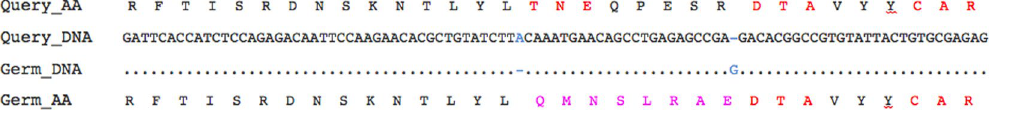
Figure 4. The igBlast alignment of a Prime Motif matching subsequence with its germline origin. The subsequence includes all three motif components; TNE, DTA, and CAR. These components have been highlighted in red. The nucleotide contents of the queried input sequence are listed on the line marked Query_ DNA. The proper amino acid translation of the query is included on the line marked Query_AA. The third line, labeled as Germ_DNA, features an alignment between the query nucleotides and the germline sequence IGHV3-53. Each dot in that alignment represents a nucleotide that has not mutated from the germline origin. The line as marked as Germ_AA contains the amino acid translation of the germline nucleotides. Based on the alignment, the query is identical to the germline, except for a single insertion and a single deletion. These indels, which are highlighted in blue, serve as endpoints of components TNE and DTA. The indels result in a localized reading frame shift, which transforms the germline subsequence QMNSLRAEDTA (highlighted in purple) into a Prime Motif associated subsequence TNEQPESRDTA.